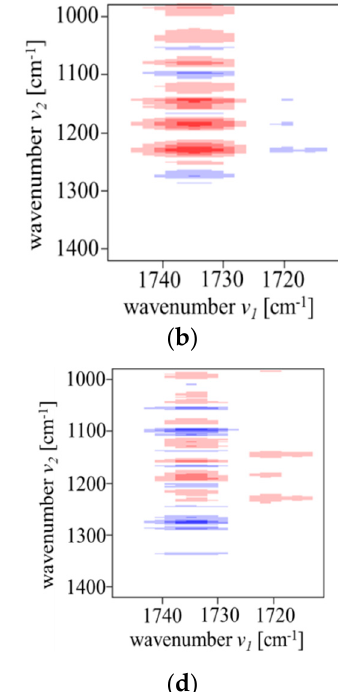
cooling mode from 349 to 259 K in the wavenumber regions of: ( a , c ) 1750–1710 cm − 1 vs. 3000–2840 cm − 1